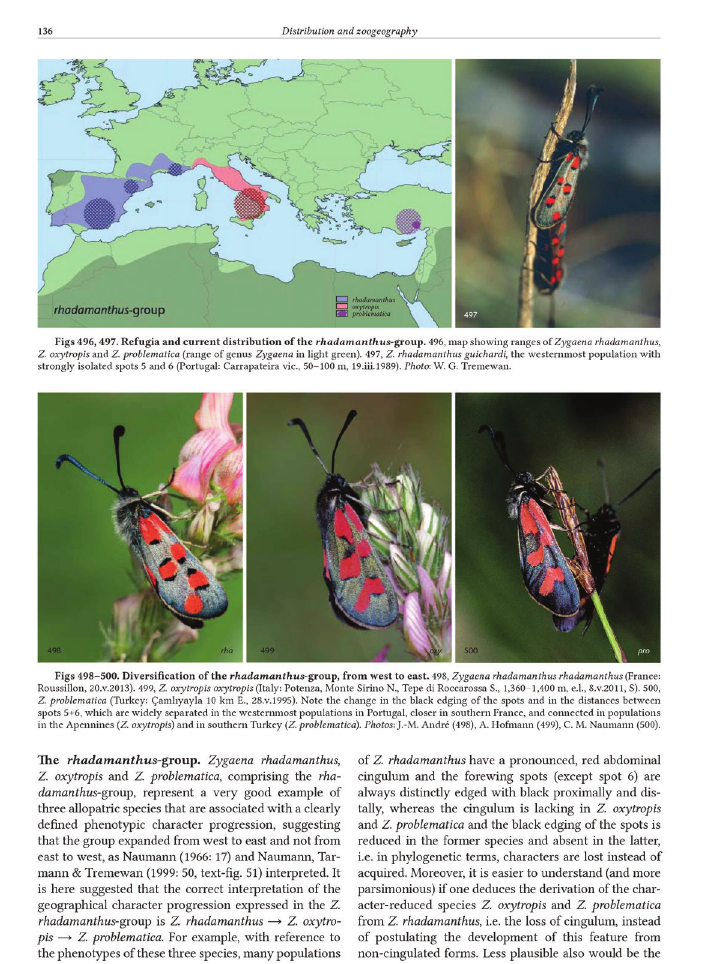
Figure 4. An example of the distribution and zoogeography of burnet moths on page 136 of the